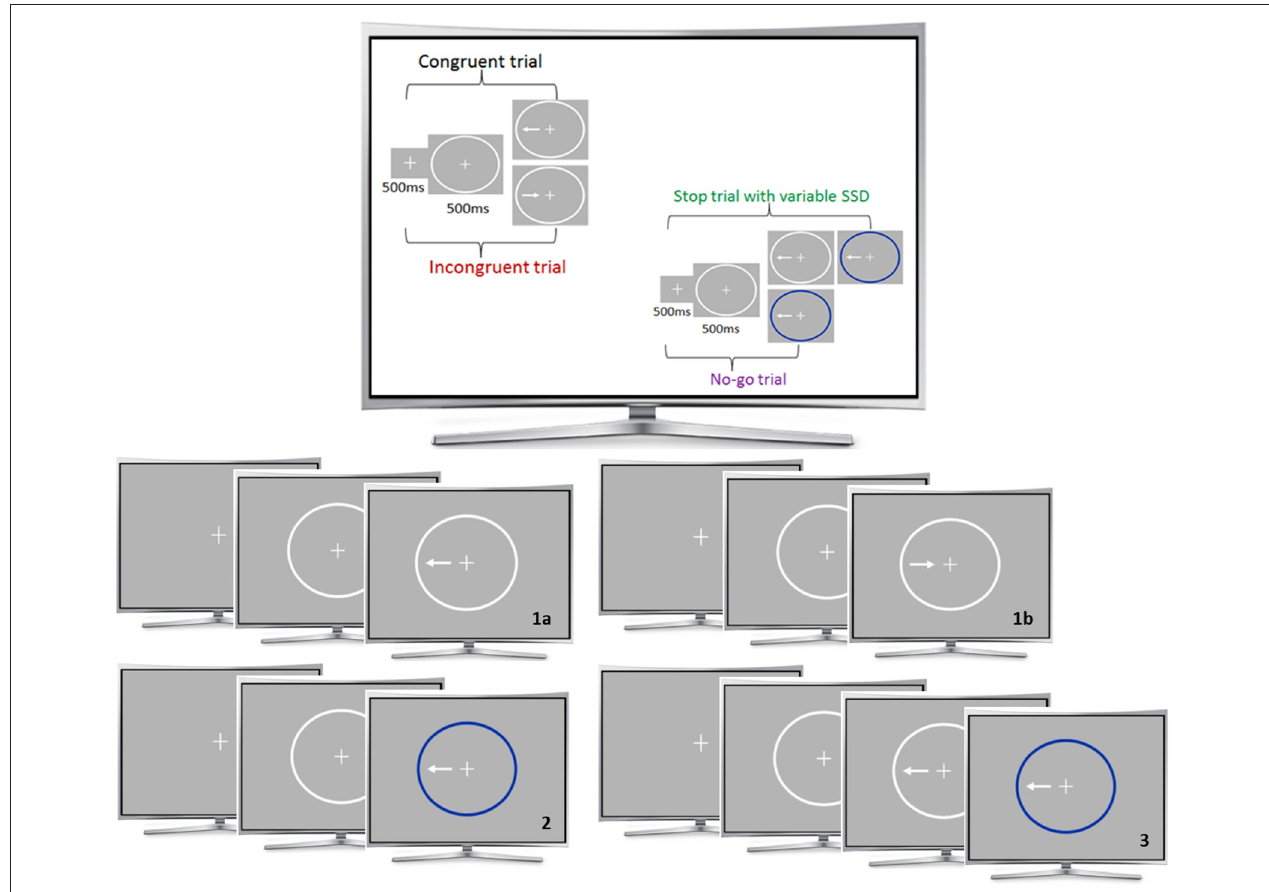
FIGURE 1 | fMRI task. The Simon-task included congruent (1a) and incongruent (1b) trials. The Go-/No-Go (2) and Stop conditions (3) consisted of congruent trials. A fixation cross was presented for 500ms at the beginning of each trial, followed by a white ellipse (500ms) and the task condition. The stop-signal delay varied between 20 and 220ms. During the 160 trials of each run, the four different stimuli conditions were presented in a pseudo-randomized order: a congruent go condition (62.5%), an incongruent go condition (12.5%), a no-go condition (12.5%) and a stop condition